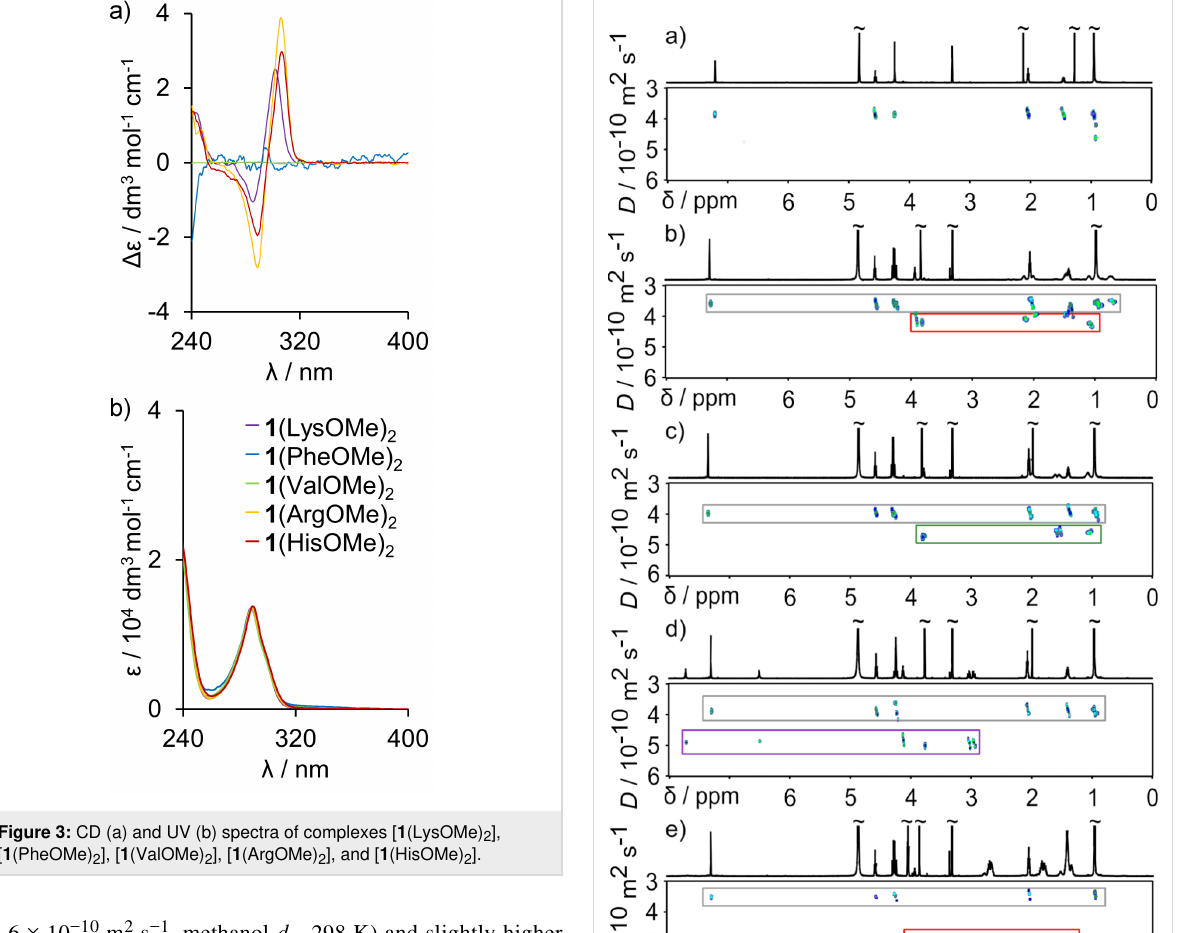
(3.6 × 10 − 10 m 2 s − 1 , methanol- d 4 , 298 K) and slightly higher value for LysOMe (4.0 × 10 − 10 m 2 s − 1 , methanol- d 4 , 298 K).